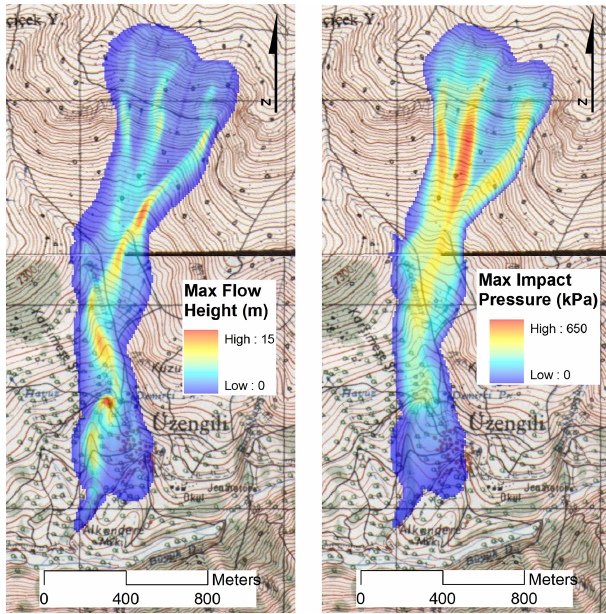
Fig. 8. Maximum flow height (left) and maximum impact pressure (right).